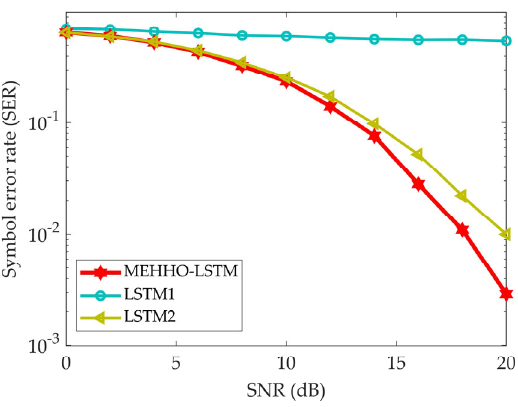
Figure 7. Performance comparison of LSTM1, LSTM2, and MEHHO ‐ LSTM methods.